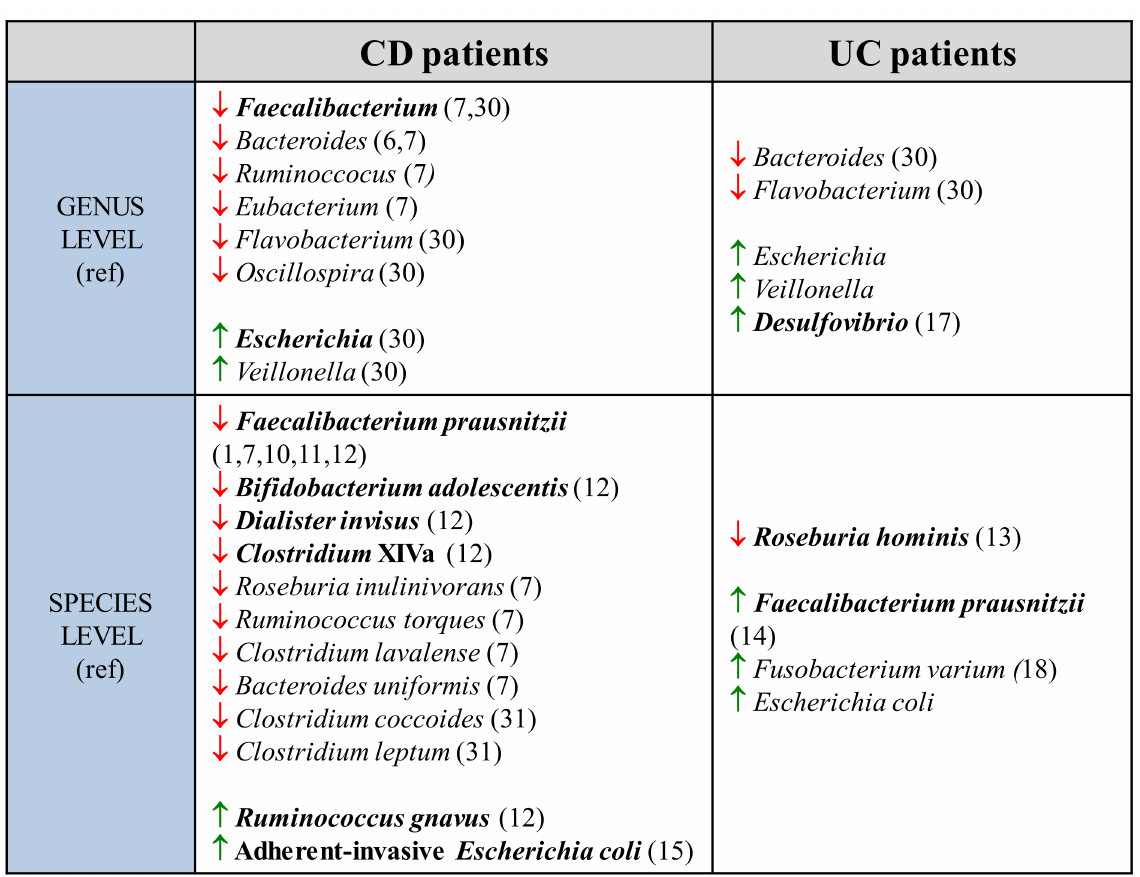
Figure 1. Taxonomic, metagenomic, metatranscriptomic and metabolomic data to evaluate microbiome composition in IBD (CD and UC patients). Comparison at genus and species levels, in CD and UC